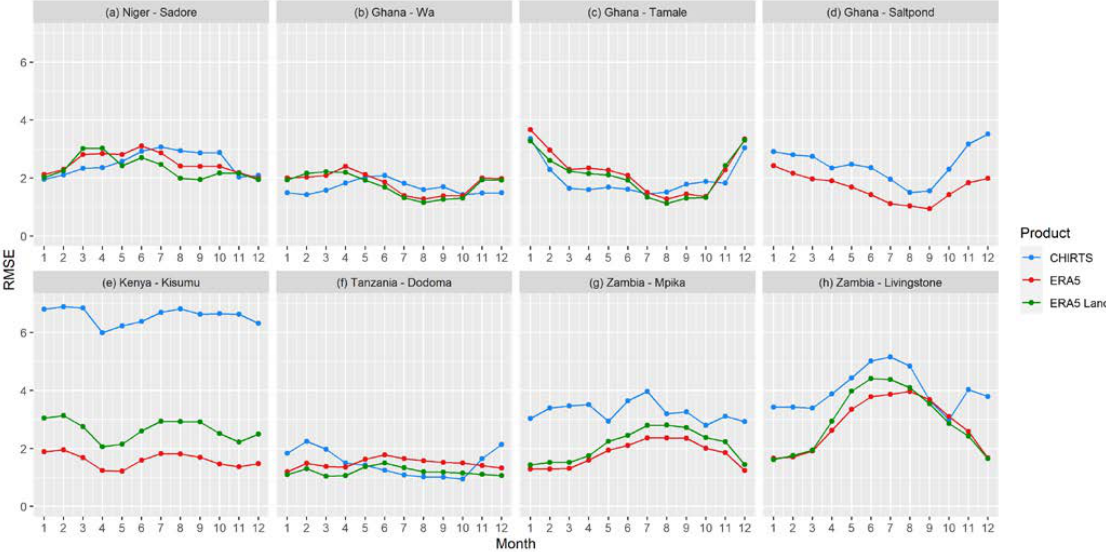
Figure 5. RMSE between station minimum temperatures and CHIRTS (blue), ERA5 (red) and ERA5- Land (green) for each month at the stations in Niger and Ghana ( a – d ) and Kenya, Tanzania and Zambia ( e – h ).